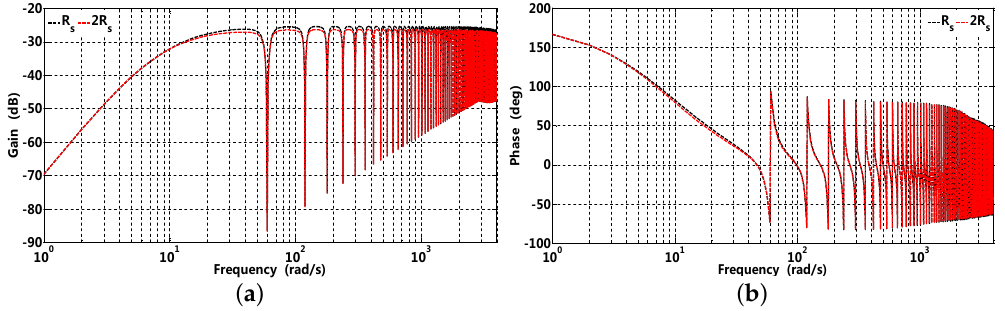
Figure 12. Gain and phase waveforms of q -axis sensitivity function with respect to resistance variation, where corresponding parameters are N = 1044, ω 0 = 60 rad/s, K q = 0.6, p = 3, D = 2.6 and